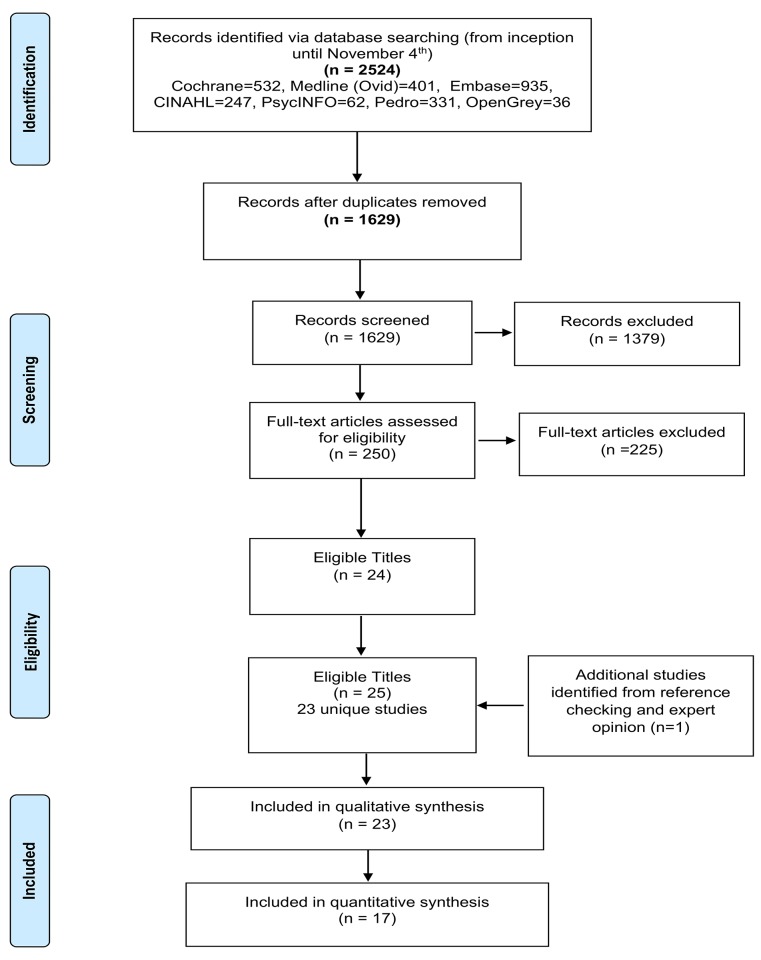
PRISMA Flow diagram.